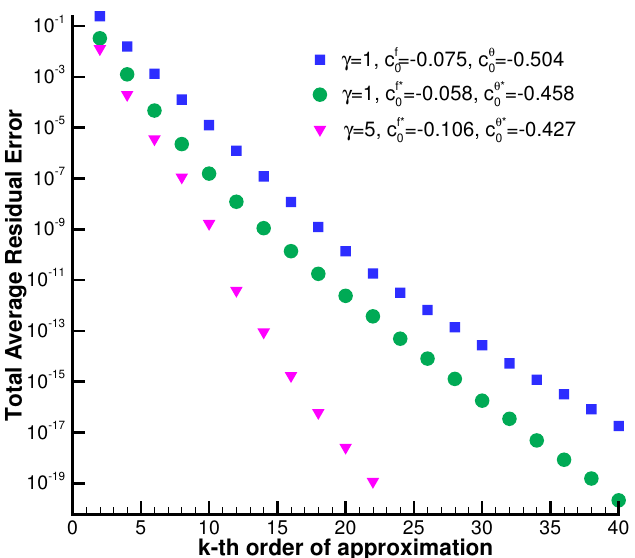
= − 0.075, 0 ∗ = − 0.106, 0